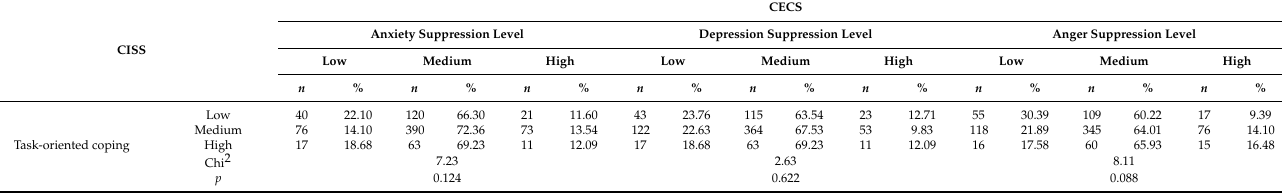
Table 7. The relationship between the styles of coping with stress according to the CISS Questionnaire and the level of anxiety, depression and anger suppression according to the CECS Emotional Control Care